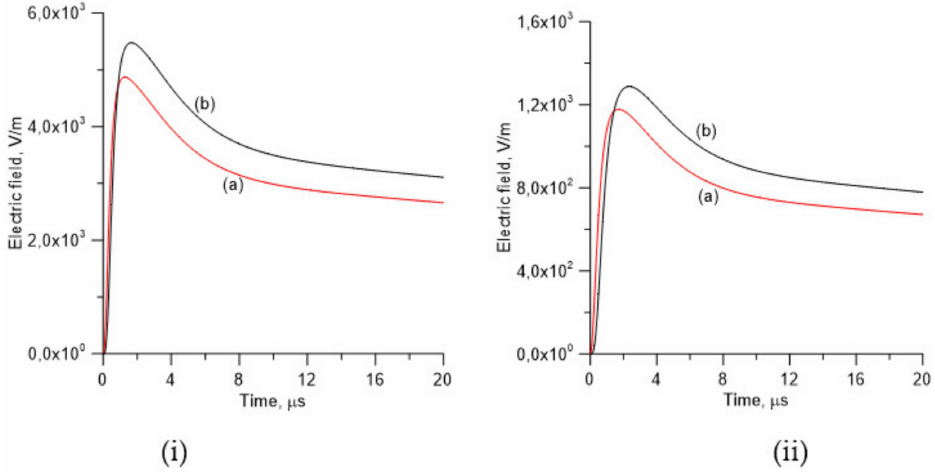
Figure 5. The horizontal electric field at the point of observation for a subsequent return stroke. ( i ) d = 50 m, ζ = 10 m; ( ii ) d = 100 m, ζ = 10 m. The speed of propagation of the pulse is 1.5 × 10 8 m/s. The curve marked (a) in red represents the exact and (b) in black represents the Rusck